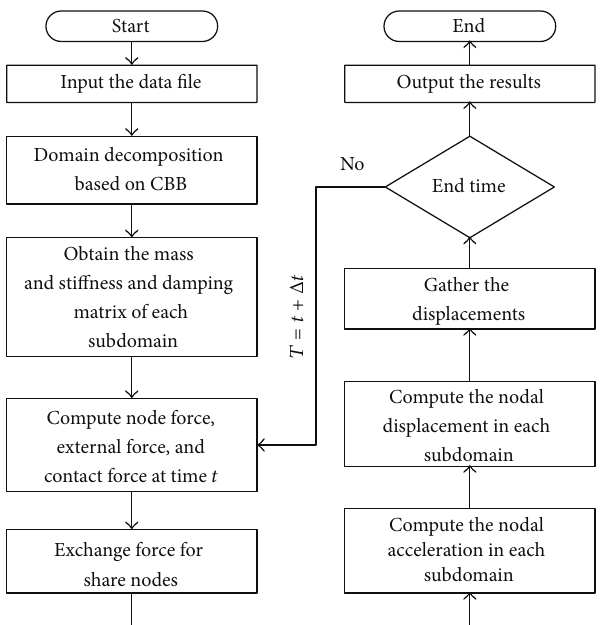
Figure 7: Flowchart of explicit finite element model parallel algorithm based on CBB.